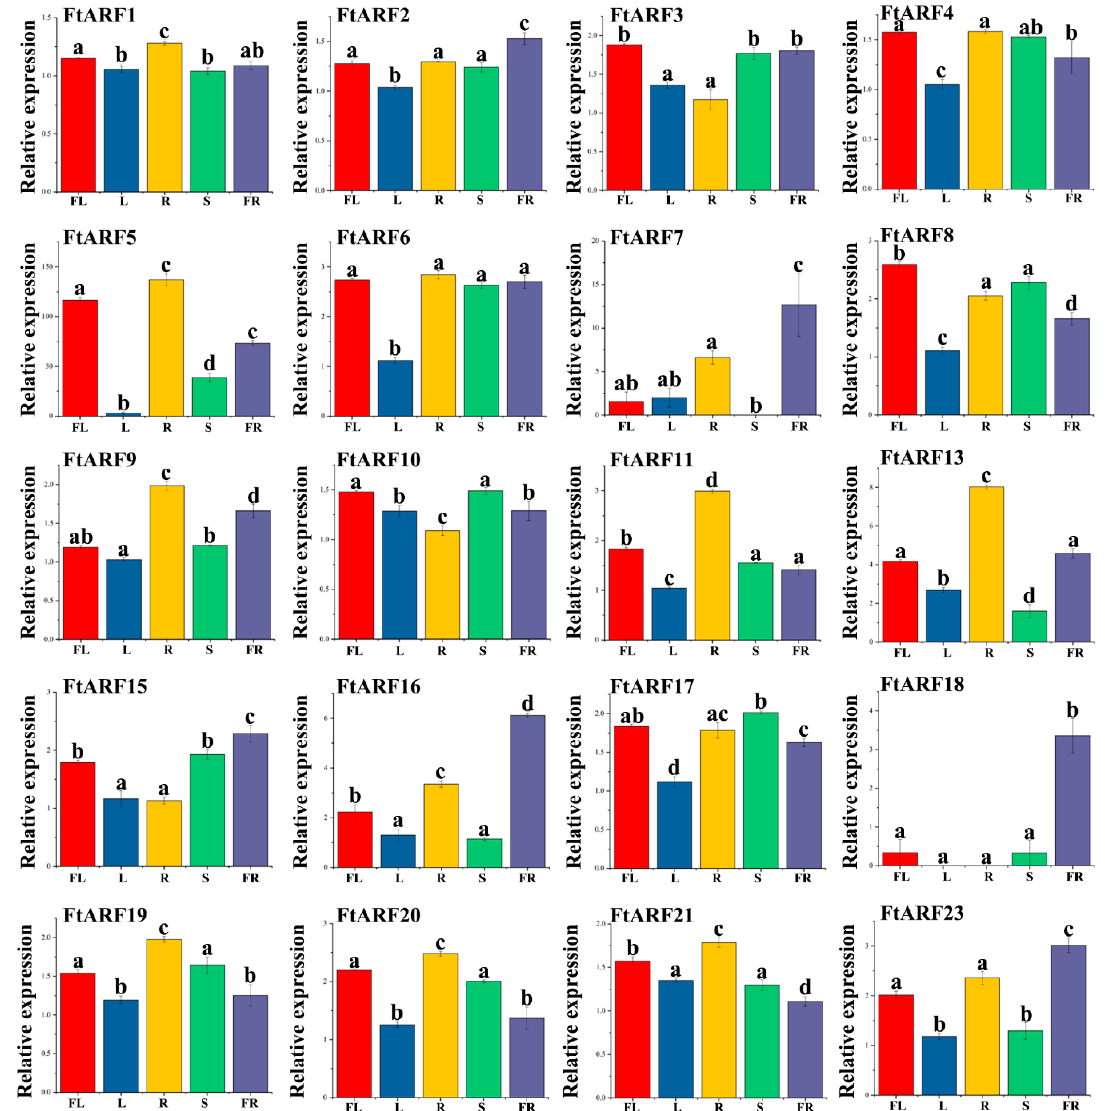
Figure 4. Expression profiles of 20 FtARF genes. The expression patterns of 20 FtARF genes in flower (FL), leaf (L), root (R), stem (S), and fruit (FR) tissues were examined by a qPCR assay. Error bars were obtained from three measurements. Small letter(s) above the bars indicate significant differences ( α = 0.05, LSD) among the treatments.